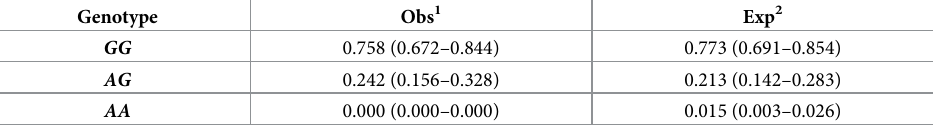
Table 2. Genotype and allele frequencies for the mutation of the SOD1 gene (SOD: c . 118G > A ) associated with CDM in German Shepherd dogs.